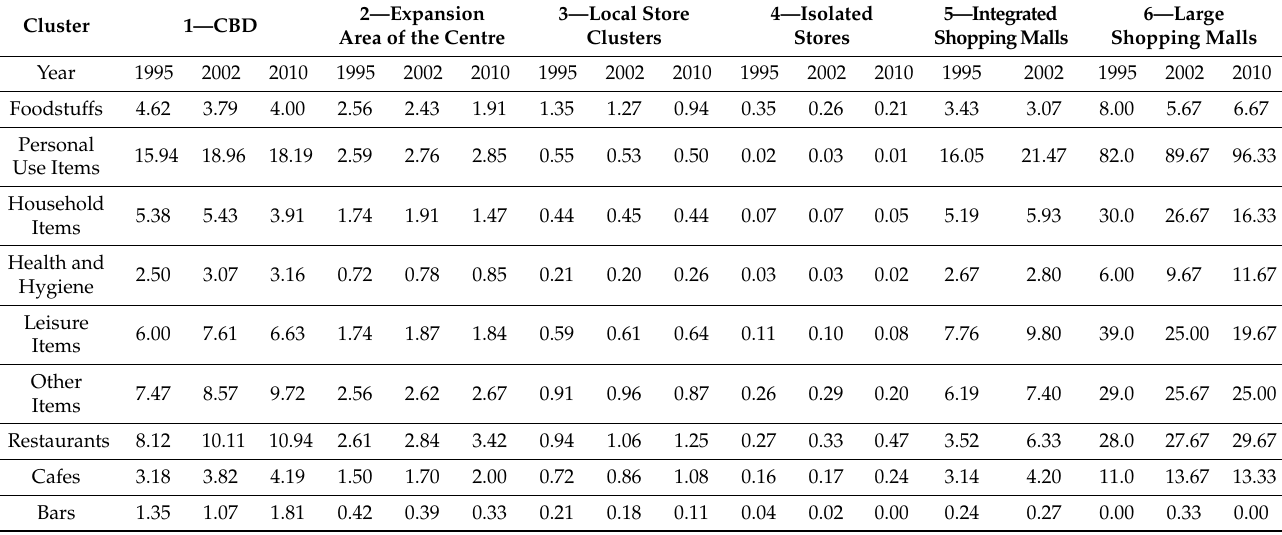
Table A1. Commercial Establishments in 1995, 2002 and 2010—Mean Number of Units considering Cluster Membership.